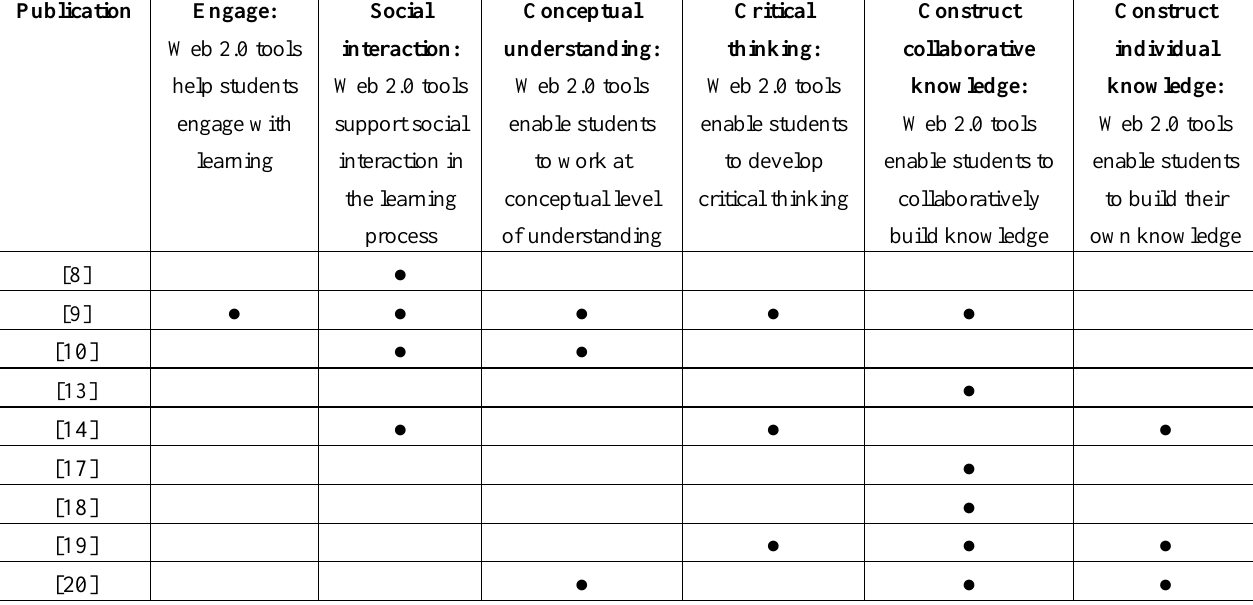
Table 1. Opportunities for learning with Web 2.0 tools in higher